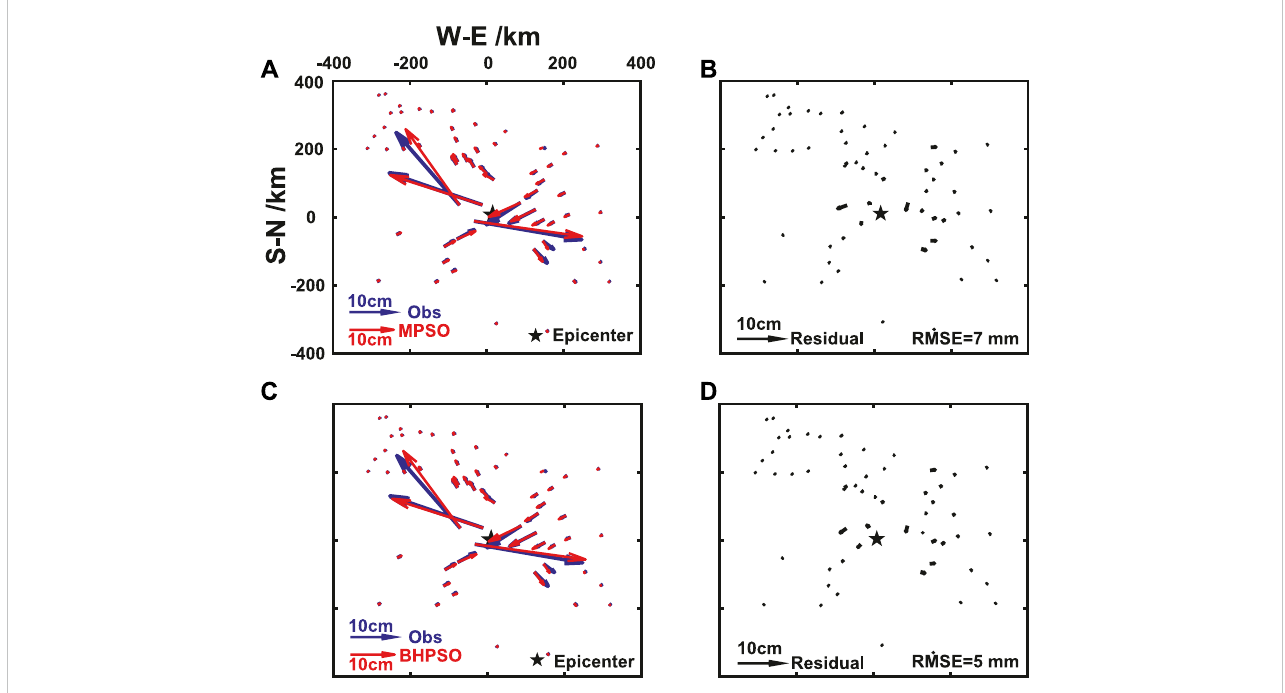
The comparisons of surface horizontal deformation (GPS data) of the observed and the Okada model results by using fault parameters given by the inversed from MPSO and BHPSO methods in Table 7. The surface horizontal deformation obtained by observed and MPSO method (A), observed and BHPSO method (C). The residual of surface horizontal deformation between the results of observed and MPSO method (B), observed and BHPSO method (D). The blue arrow and its length represent the displacement from GPS data, the red arrow and its length represent the inversion results from MPSO or BHPSO. The black arrow and its length represent the residuals.